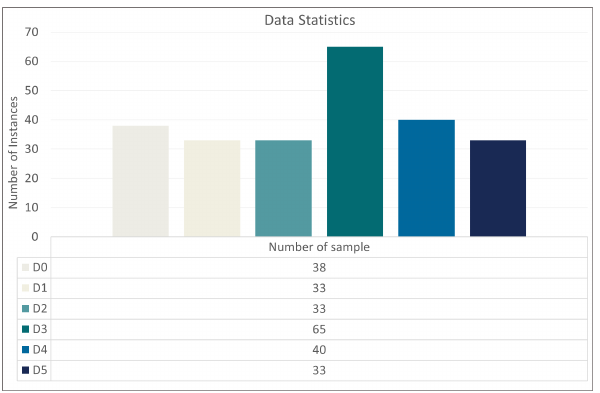
Figure 2. Statistics about the total of damage cases inside the underlying